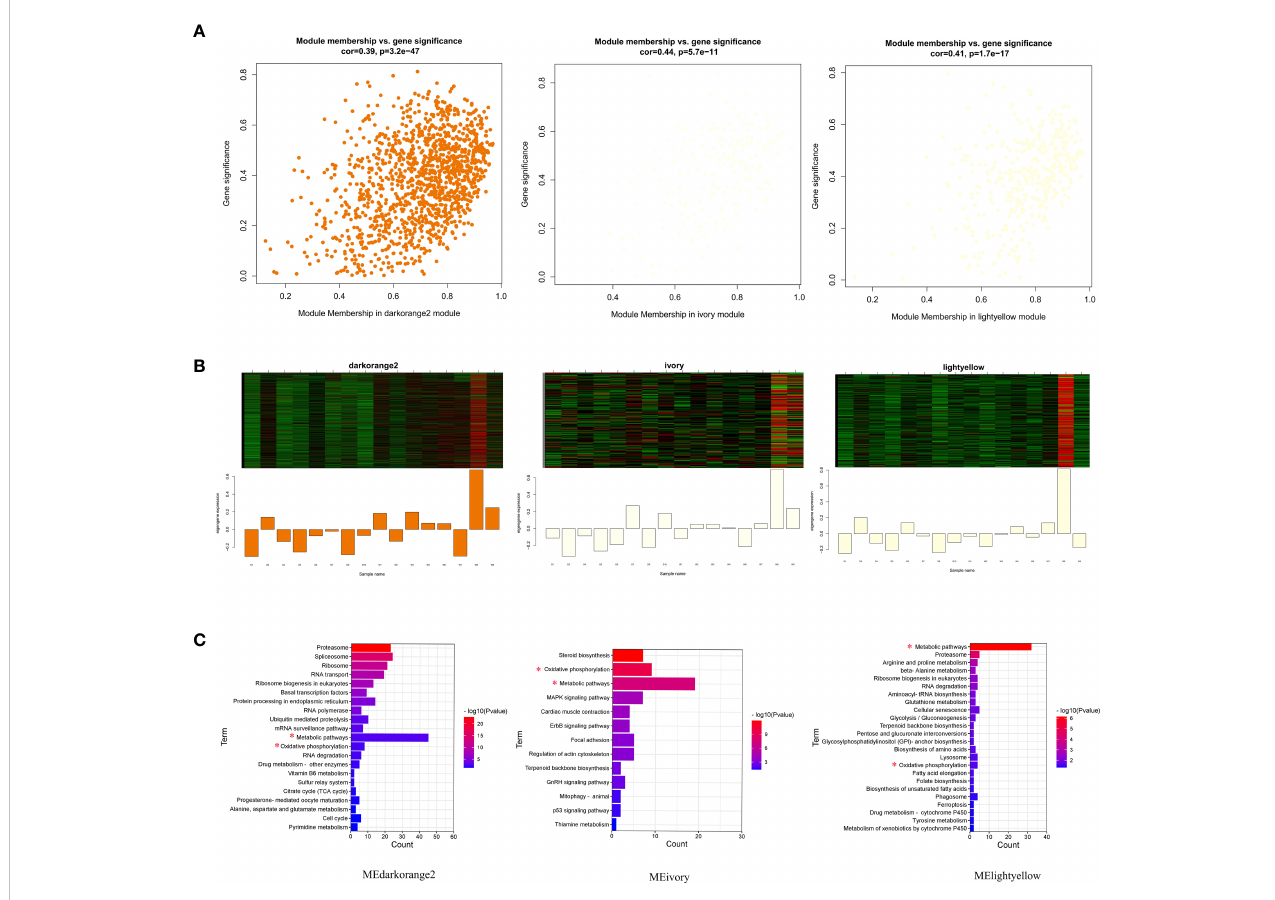
FIGURE 5 Visualization of gene signi fi cance (GS) vs. module membership (MM), expression levels and functional enrichment in three signi fi cantly related modules. (A) A scatterplot of GS for phagocytosis index and phagocytosis rate vs. MM in modules; (B) The heatmap and bar plot represent the expression level of genes in three modules. (C) Pathway enrichment analysis of all genes in three signi fi cantly correlated modules. Pathways coenriched by the three modules are marked with a red asterisk.